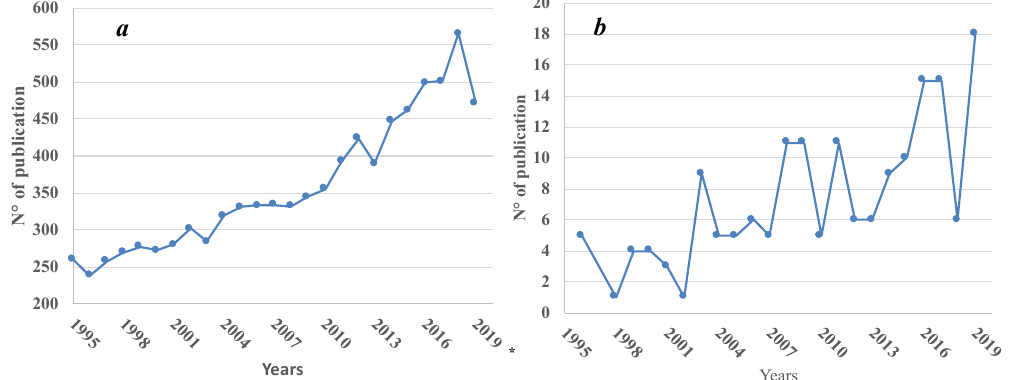
Figure 2. Temporal evaluation of scientific publications on biogenic amines (BAs). Keywords: “Biogenic Amines” ( a ), “Biogenic Amines” + “Beverages” ( b ). (* 2019 unfinished